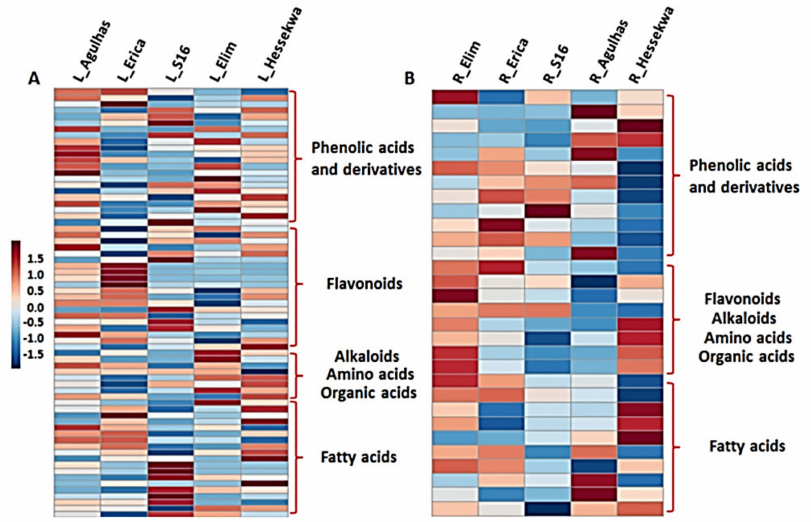
Figure 4. Heatmap overview of the distribution of annotated metabolites present in extracts from ( A ) leaf and ( B ) roots of different barley cultivars: ‘Agulhas’, ‘Erica’, ‘S16’, ‘Elim’ and ‘Hessekwa’. The colour scale was set to default ranging from red (high) to blue (low). L = leaf extracts, R = root extracts. Each cell represents the average peak intensity values ( n = 9) of specific metabolites within the indicated specific